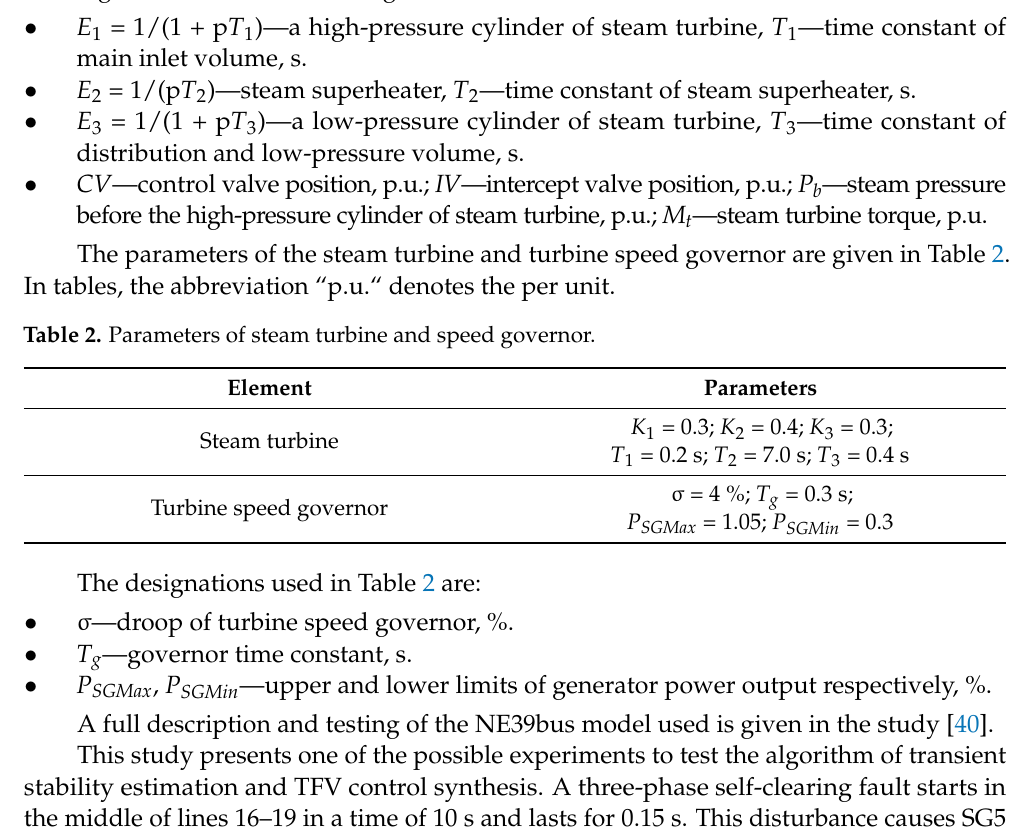
Table 2. Parameters of steam turbine and speed governor.